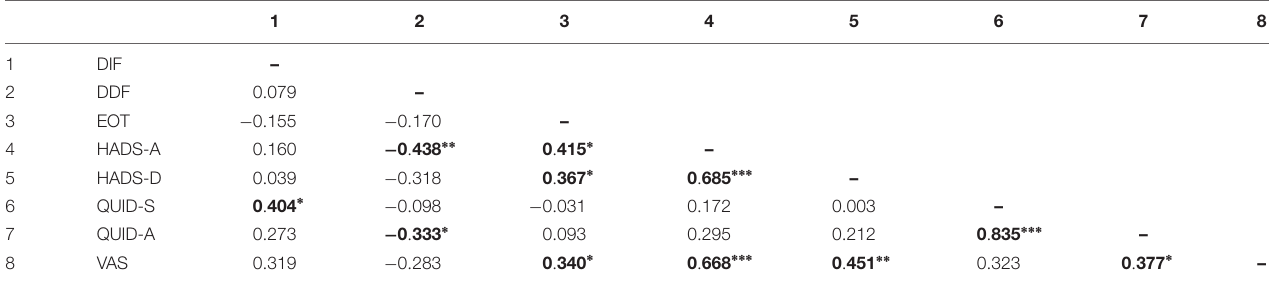
Same abbreviations as Table 2 . Bold data indicate correlations that are significant. ∗ p < 0.05; ∗∗ p < 0.01; ∗∗∗ p < 0.001.